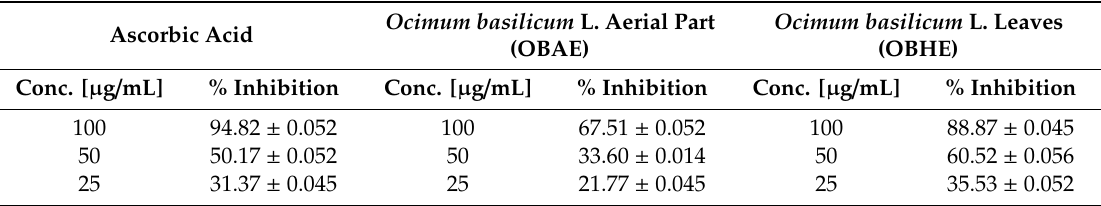
Table 3. The percent of inhibition antioxidant activity (AOA) induced by ascorbic acid as compared to Ocimum basilicum L. aerial part and leaves hydro-alcoholic